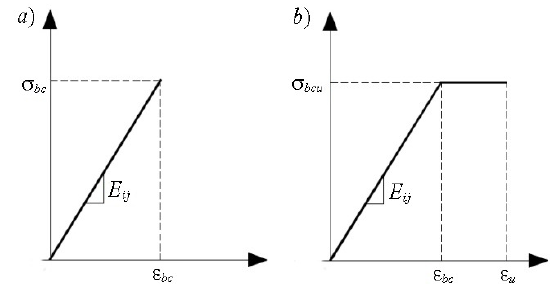
Fig. 1. Stress-strain diagram when compressive stress is applied (AFGC-SETRA